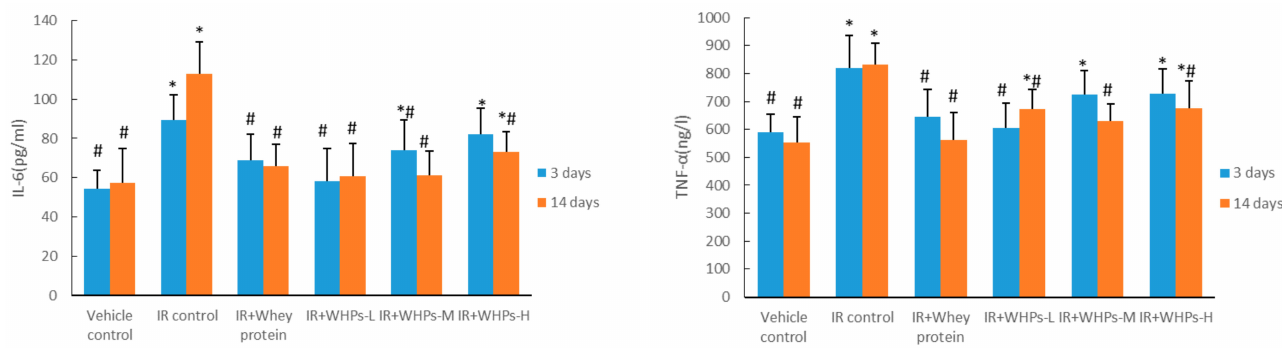
Figure 5. Effect of WHPs on inflammatory cytokine levels in serum. * The difference was statistically significant ( p < 0.05) compared with the vehicle control group; # the difference was statistically significant ( p < 0.05) compared with the IR control group. IR, irradiated mice; IR+WHPs-L, irradiated mice+low-dose whey hydrolysate peptides; IR+WHPs-M, irradiated mice+medium-dose whey hydrolysate peptides; IR+WHPs-H, irradiated mice+high-dose whey hydrolysate